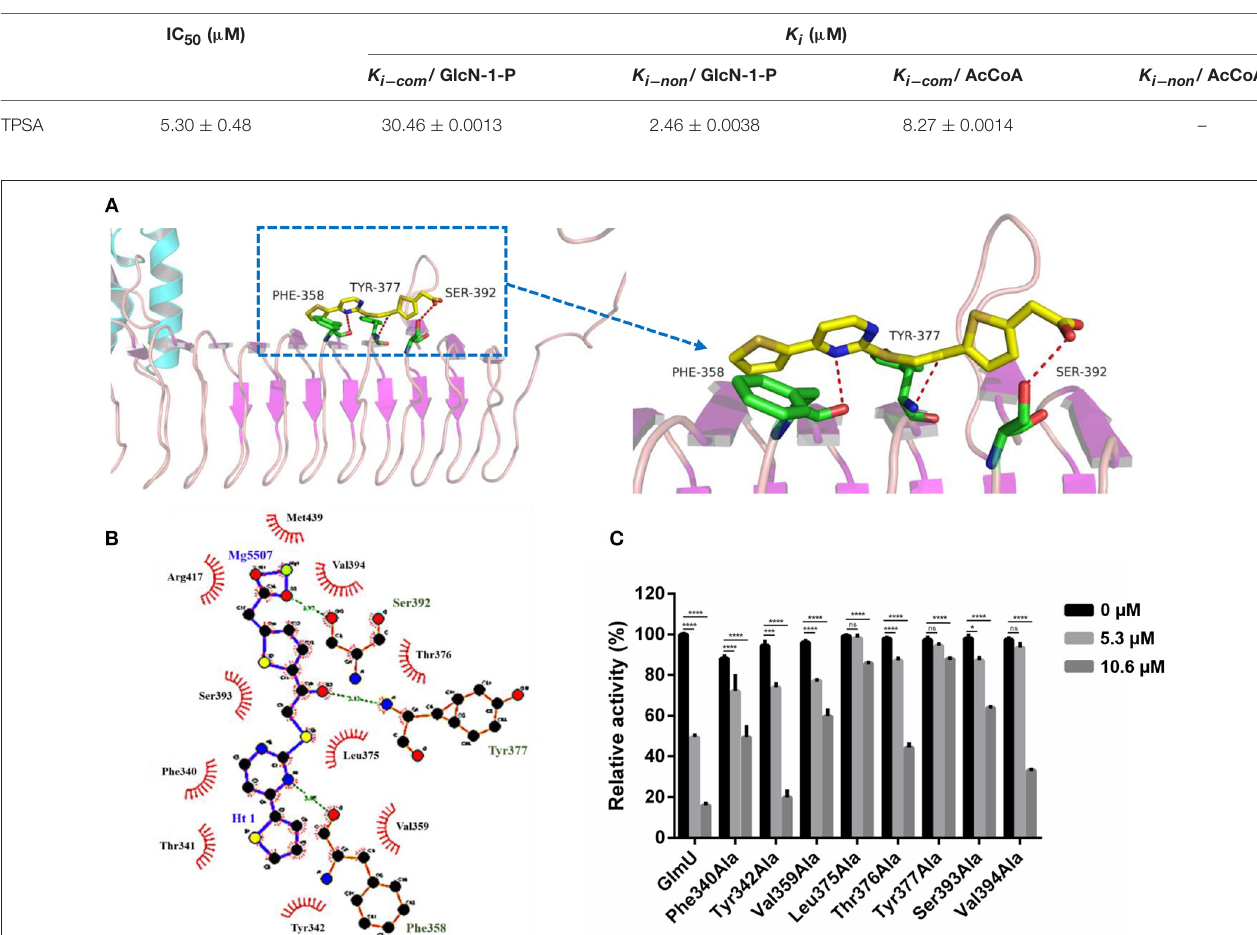
TABLE 1 | The inhibition of TPSA on GlmU acetyltransferase.